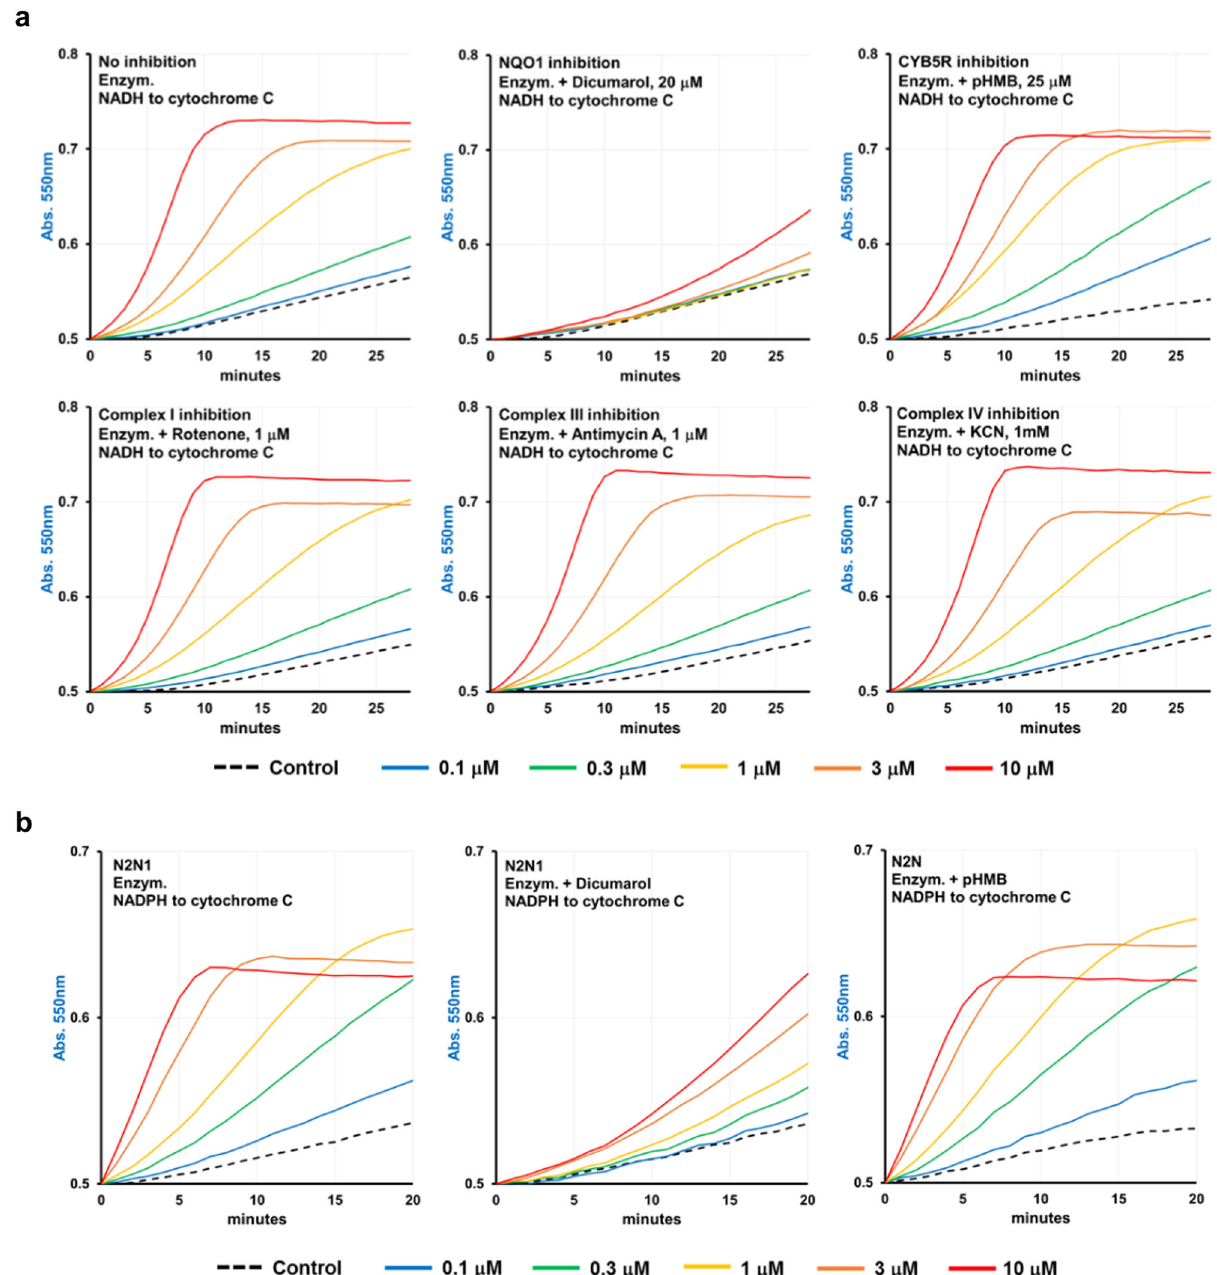
Fig. 5 Evaluation of N2N1 assisted enzymatic reduction of cytochrome c with a set of enzyme-speci fi c inhibitors identi fi ed NQO1 as a partner protein for N2N1-mediated anti-aging activities. Both NADH and NADPH can be the electron donors in N2N1 assisted NQO1 driven reaction. a Several inhibitors were added to the NADH containing reaction mix: dicumarol for NQO1, pHMB for CYB5Rs, rotenone for mitochondrial Complex I, antimycin A for mitochondrial Complex III and cyanide for mitochondrial Complex IV. Dicumarol treatment (upper middle plot) completely erased the effect of N2N1 on enzymatic electron transfer from NADH to cytochrome c. Table S5 shows the reaction rates after addition of the inhibitors and control samples. b The enzymatic, N2N1 assisted, NADPH-dependent reduction of cytochrome c was also inhibited only by dicumarol, pointing on NQO1 as a partner of N2N1. The residual, not-inhibited by dicumarol NADPH : cytochrome c electron transfer may indicated possible acceleration of some CYP driven enzymatic activities by N2N1. Table S6 shows the reaction rates after